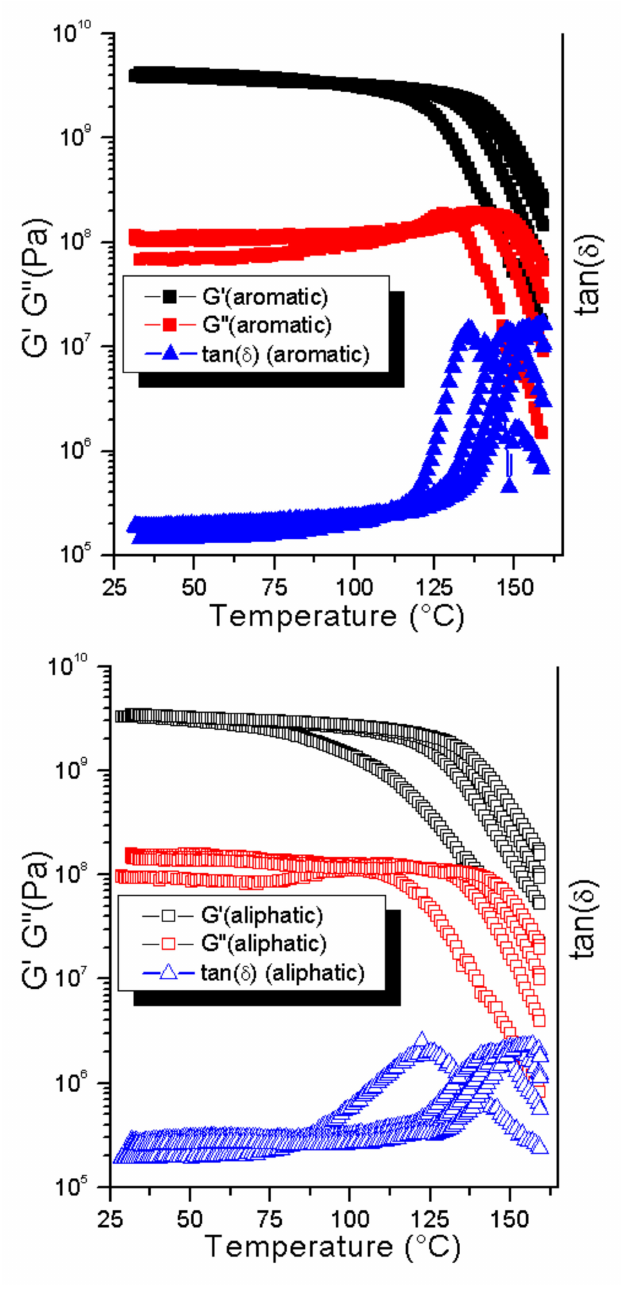
Figure 8. Cyclical DMTA measurements using the aromatic crosslinker ( top ) and the aliphatic crosslinker ( bottom ). Only the heating steps are